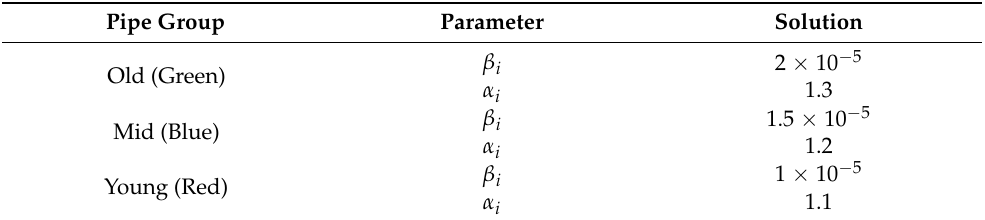
Table 3. Values of α i and β i for net 3-b (the assumption is that the calibration has already been done).